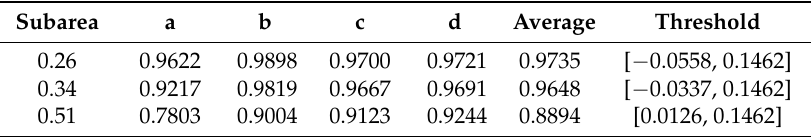
Table 1. Value of L/K under different ISA proportions in four subareas.